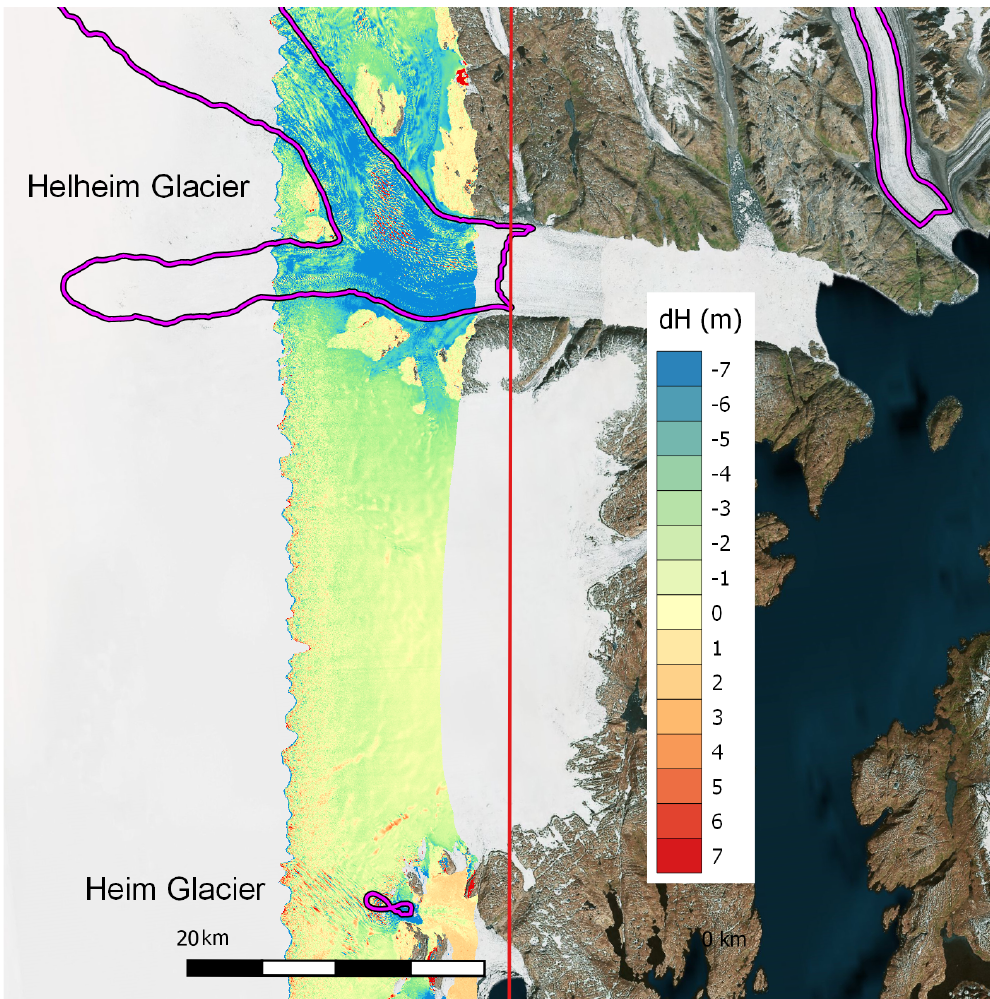
Figure 10. Map showing the difference (2017–2016) between GLISTIN-A elevation maps collected in subsequent years. Purple contours show regions with glacier speeds greater than 1000 m per year. The red line shows the path of the aircraft and instrument. Overlaid on Bing Aerial image of the